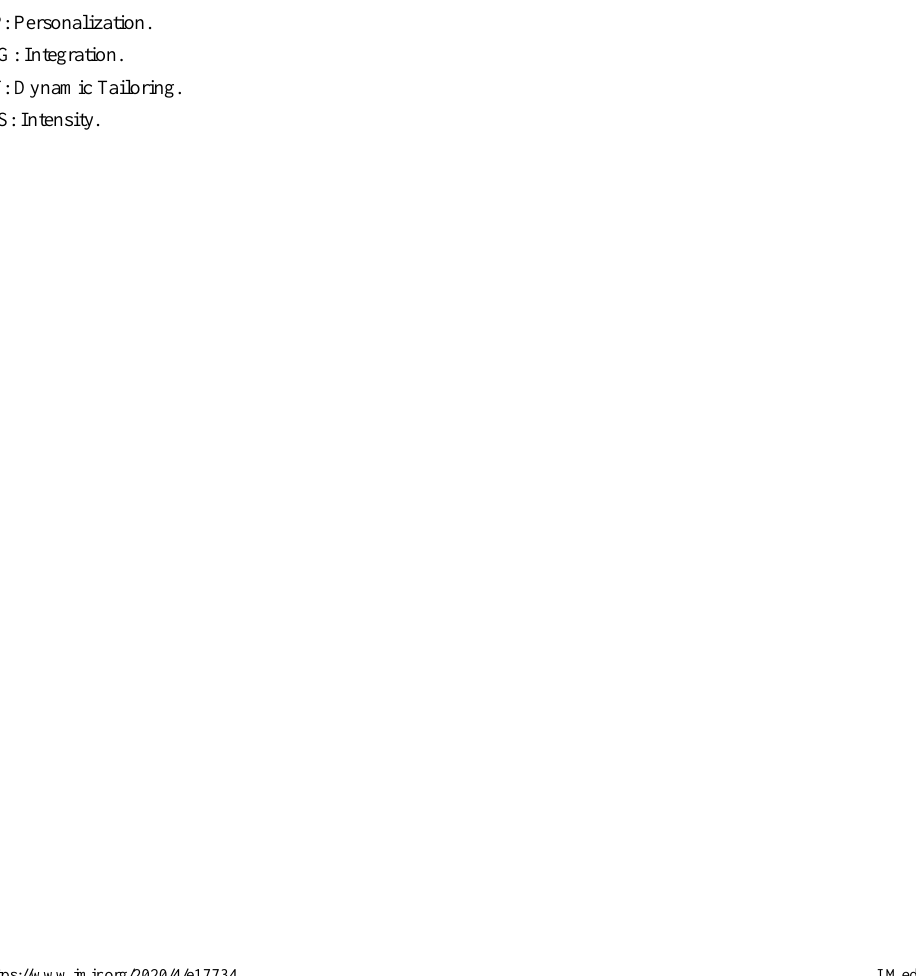
Interactive FeatureFactor a